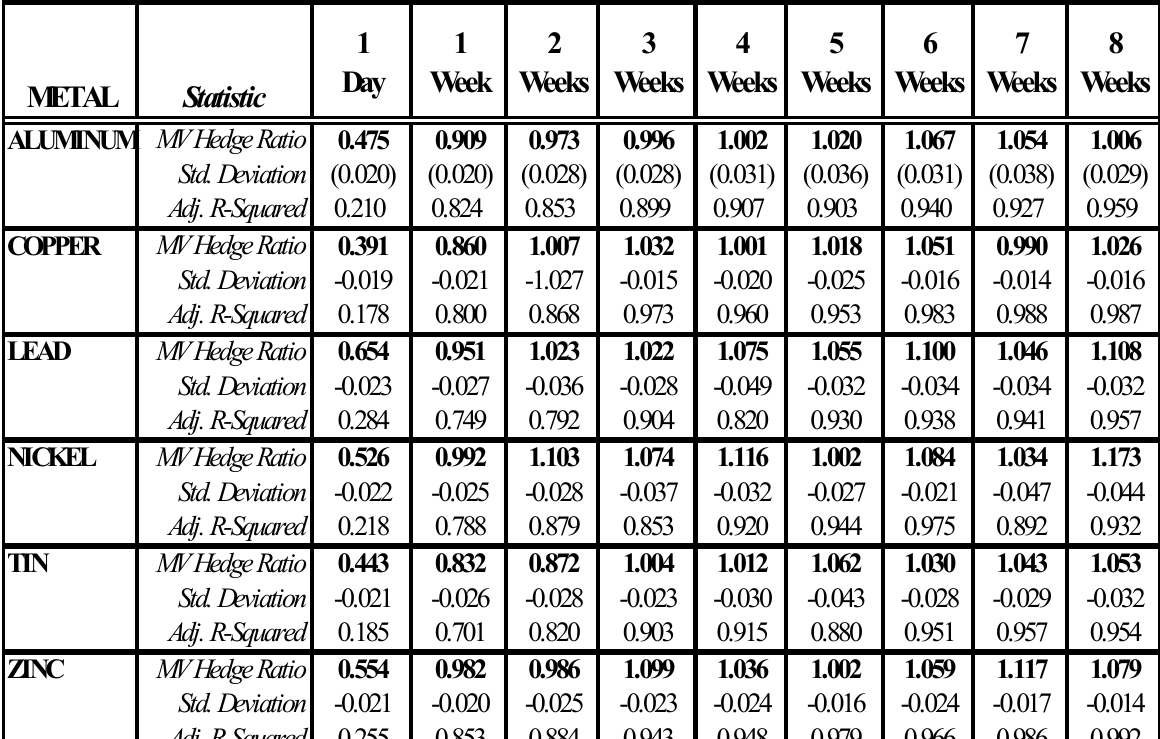
TABLE 4- OLS Minimum Variance Hedge